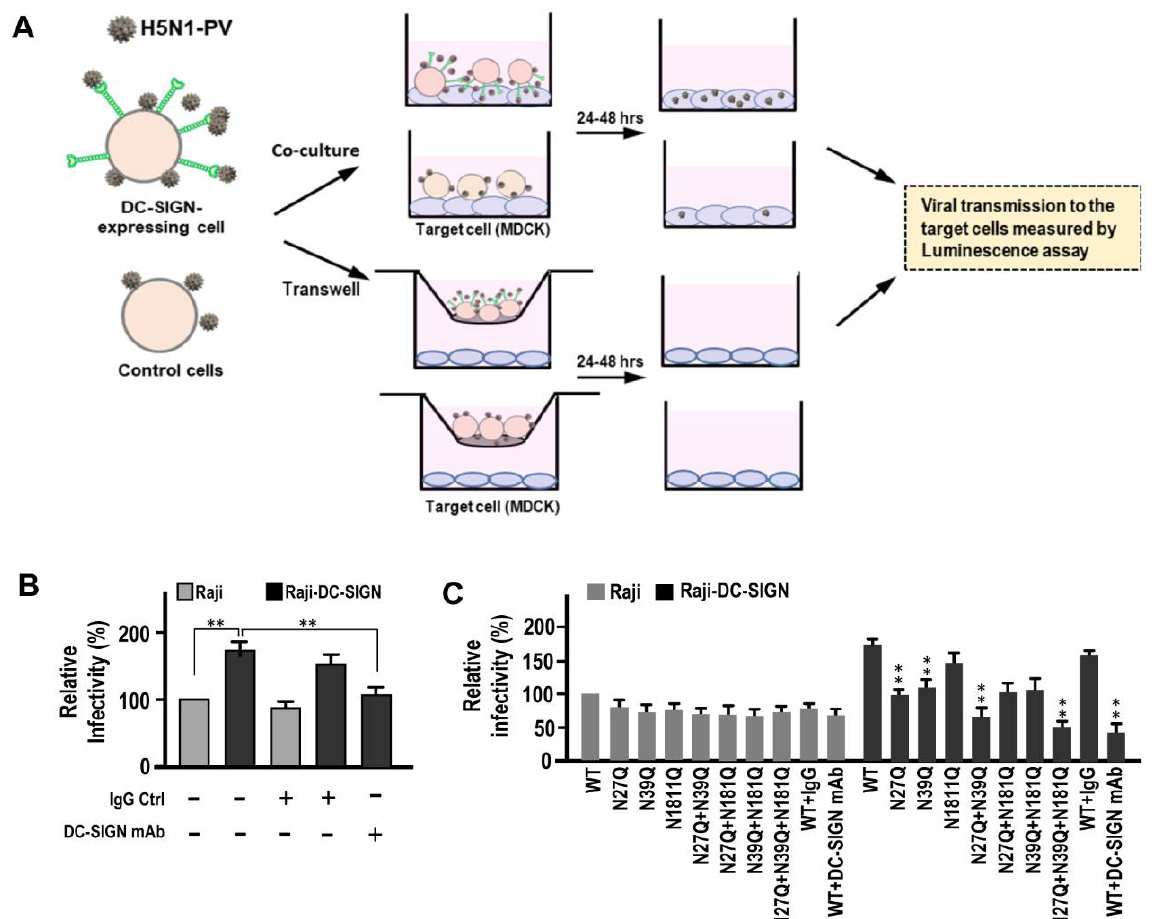
Figure 6. Evaluation of DC-SIGN mediated trans infection among H5N1-PVs carrying N-glycosylation mutations. ( A ) The scheme of modified conventional capture assay is demonstrated. ( B ) Raji and Raji-DC-SIGN were used as captured cells. They were incubated with H5N1-PVs at 4 ◦ C for 2 h and then co-cultured with MDCK (target cells) at 37 ◦ C for 24–48 h. After co-culturing, the capture cells were removed via intensive PBS washing (three to five times) and the target MDCK cells were subjected to luminescence analysis. In addition, for detecting the virions budding from cis infection, the transwell system was used to monitor those virions released from captured cells further causing MDCK (target cells) infection. The lower channel of infected MDCK cells in the transwell were also subjected to luminescence analysis. Alternatively, some groups were co-treated with IgG control and anti-DC-SIGN monoclonal antibodies. The relative infectivity was measured by using the luminescence values of co-cultured MDCK, normalized with values of MDCK from transwell system. ( C ) The Raji and Raji-DC-SIGN cells (captured cells) were incubated with H5N1-PVs carrying different N-glycosylation mutations on HA at 4 ◦ C for 2 h and then co-cultured with MDCK (target cells) at 37 ◦ C for 24–48 h. After co-culturing, the capture cells were removed via intensive PBS washing (three-five times) and the target MDCK cells were subjected to luminescence analysis. Similarly, the detection of the virions released from cis infection of the captured cells was monitored using transwell system mentioned above. Alternatively, some groups were co-treated with IgG control and anti-DC-SIGN monoclonal antibodies. The relative infectivity was measured by using the luminescence values of co-cultured MDCK, normalized with values of MDCK from transwell system. The significant difference was measured by each N-glycosylation mutant compared to WT group. Representative results are shown. Quantitative data represent the means ± SD of results from at least three independent experiments (WT, wild-type) (* p < 0.05; ** p <